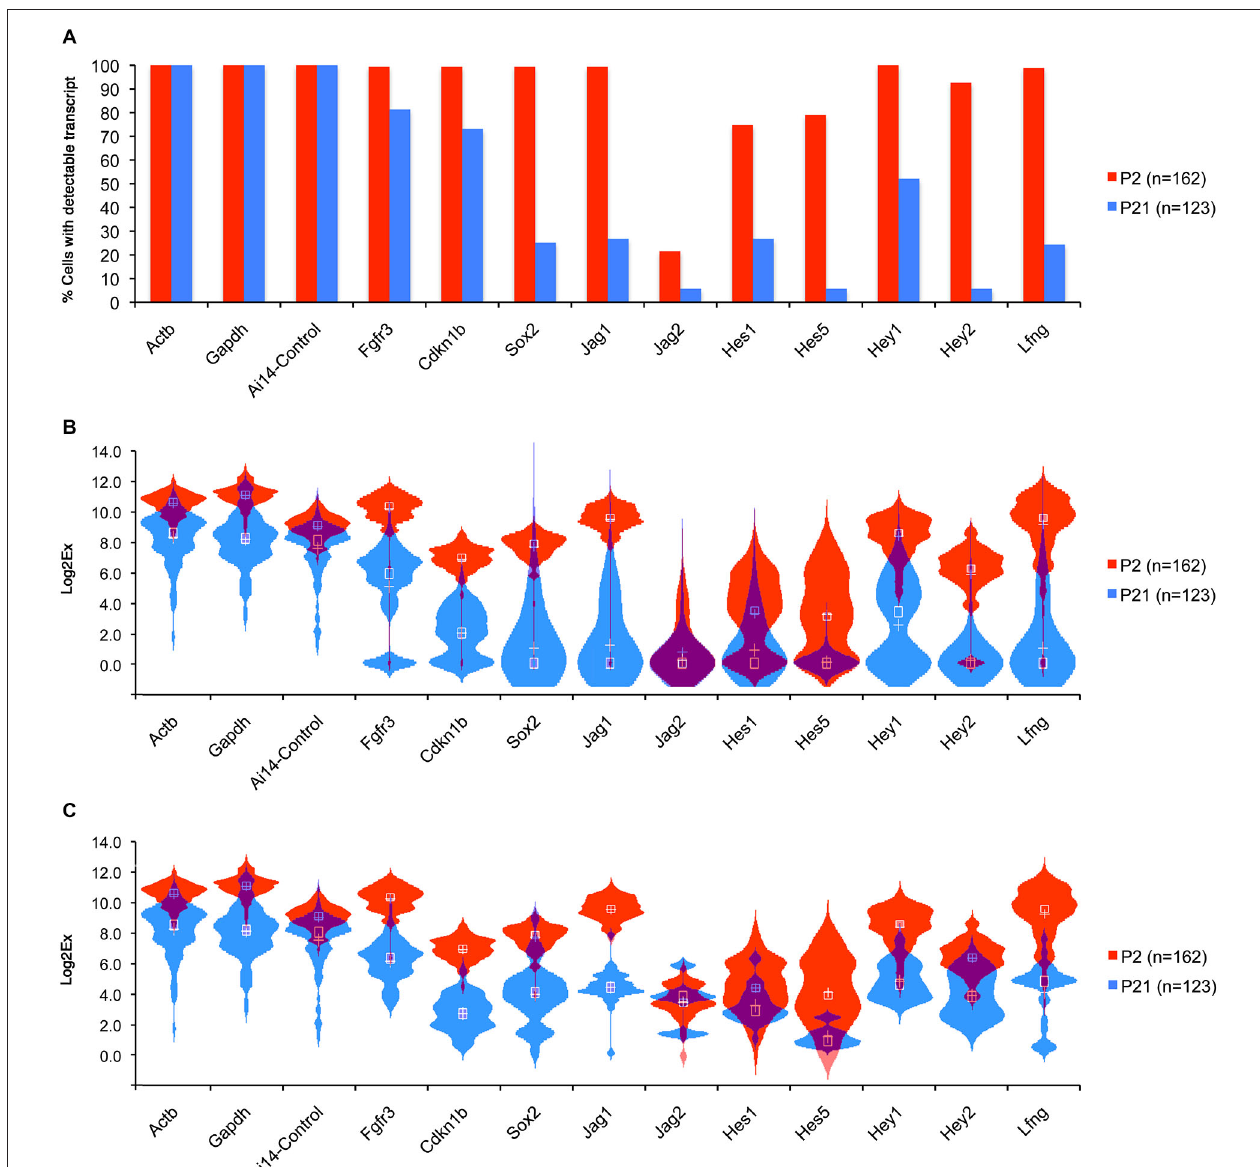
age that expressed detectable levels of each gene under analysis. (B) Violin plot showing the distribution of expression levels for each gene in all cells including the cells with no expression (Log2x = 0) presented in a combination of box plots and kernel density plots. White Crosses indicate the mean, white boxes the median expression levels. (C) Violin plot similar to (B) , excluding cells with undetectable levels of expression for each